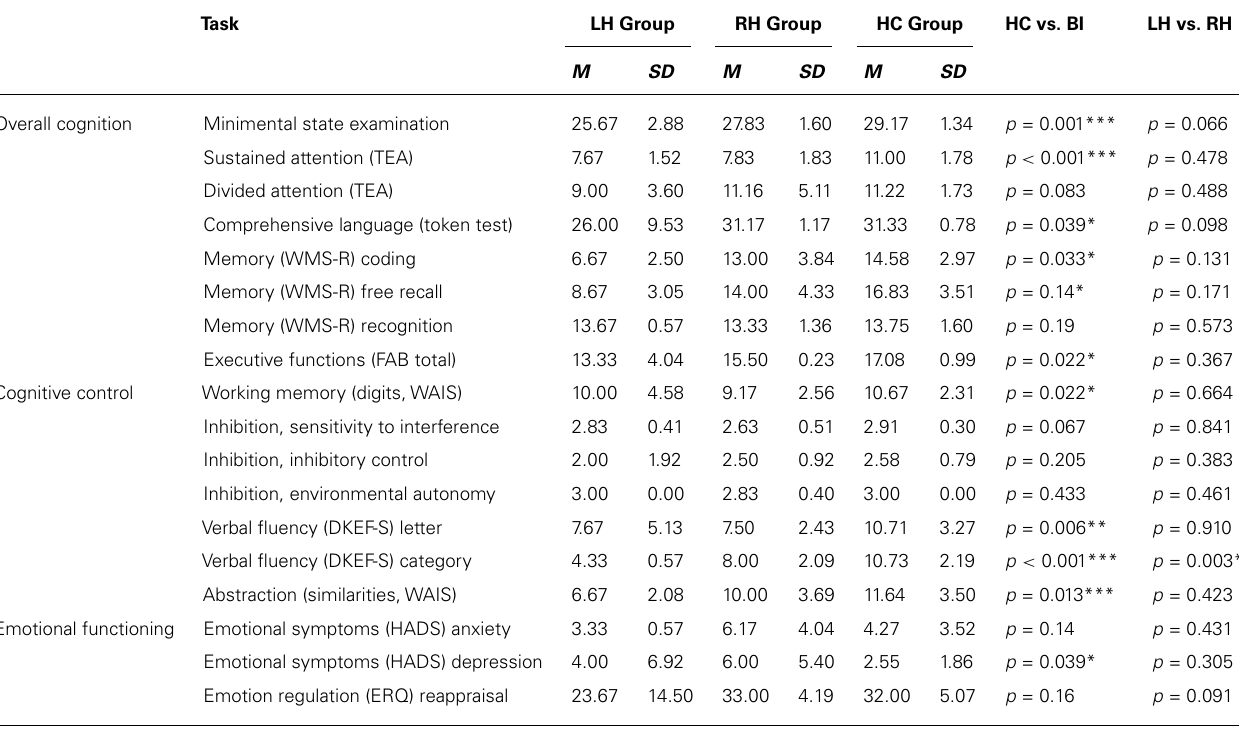
Table 2 | Cognitive and emotional performance of neurological groups and healthy